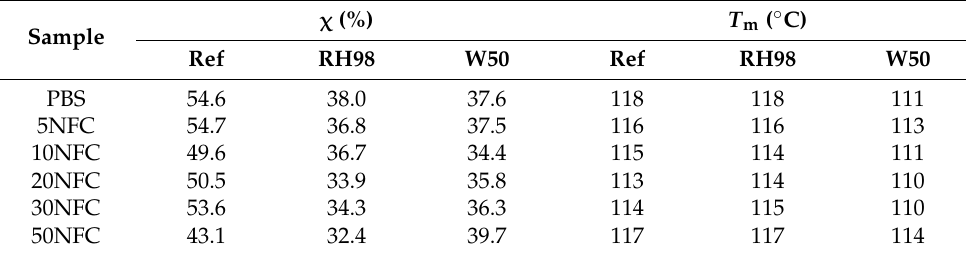
Figure 9. DSC first heating curves for reference and aged PBS/NFC samples. Table 2. Calorimetric characteristics of PBS/NFC for reference and aged samples (1st heating